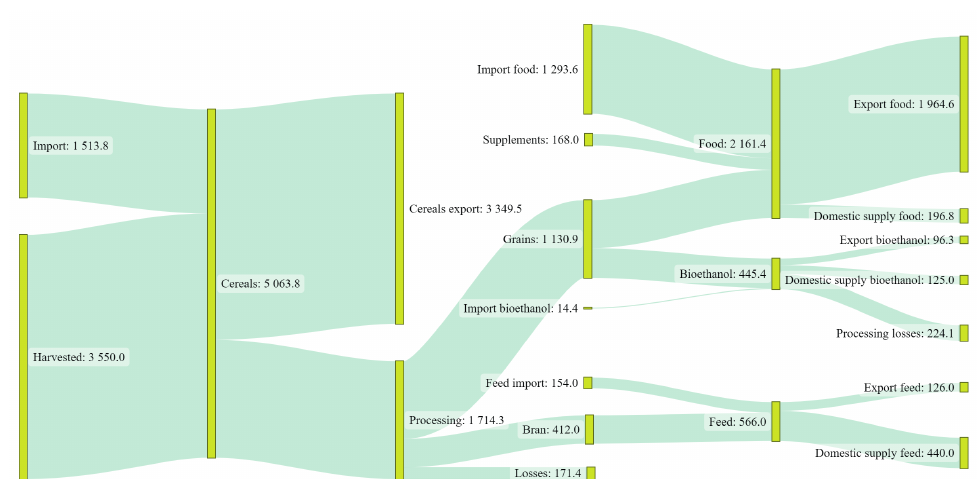
Fig. 3. Sankey diagram for bioresource flows of base scenario in 2030 for cereals, thousand tonnes.